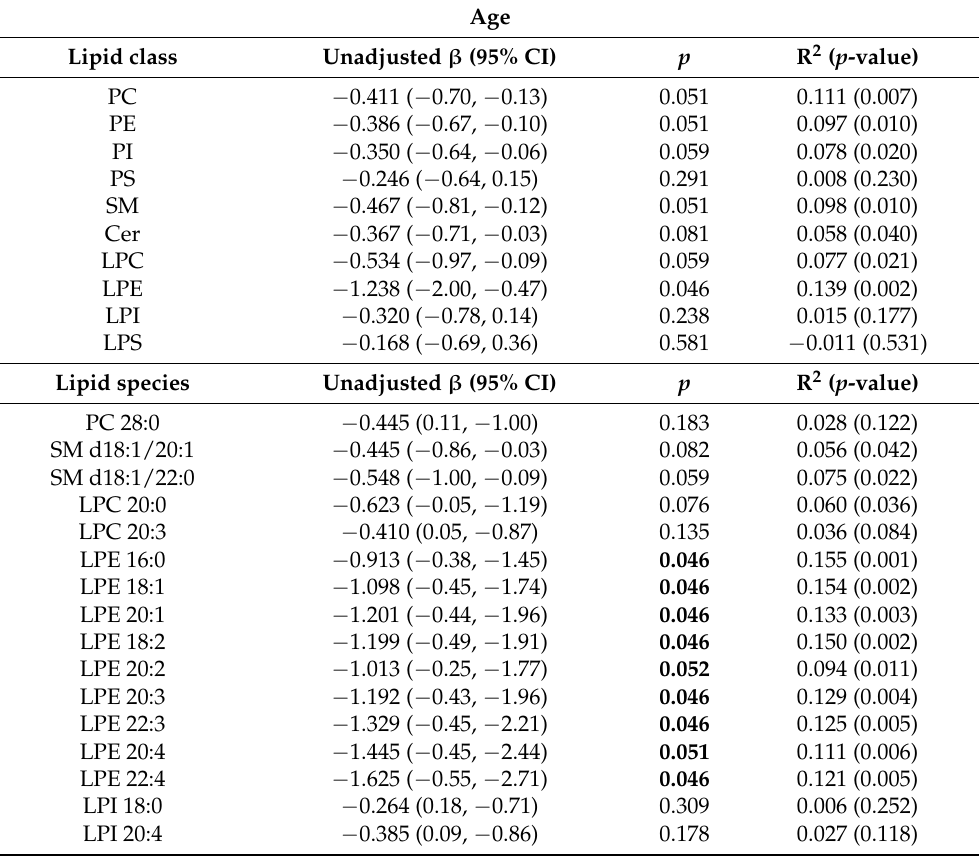
Table 2. Univariable associations between selected lipid species or classes and